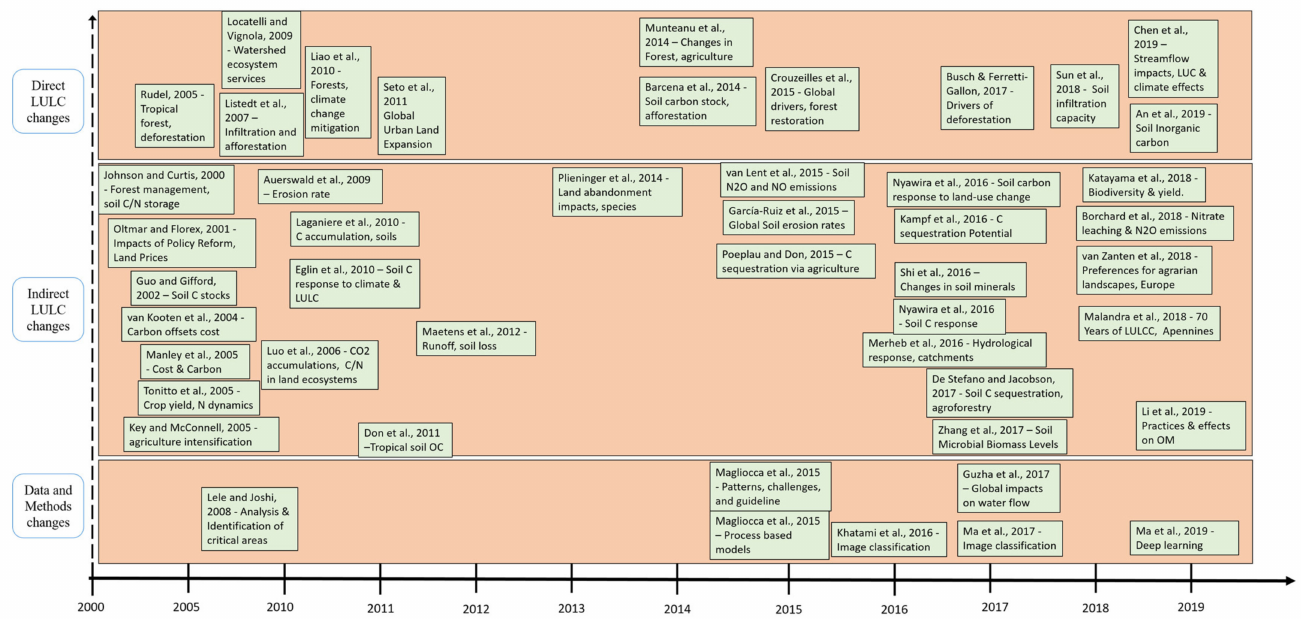
Figure 3. Diagram showing meta-studies timeline of